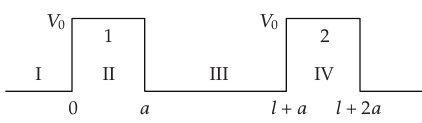
Figure 7: Tunneling through two successive potential